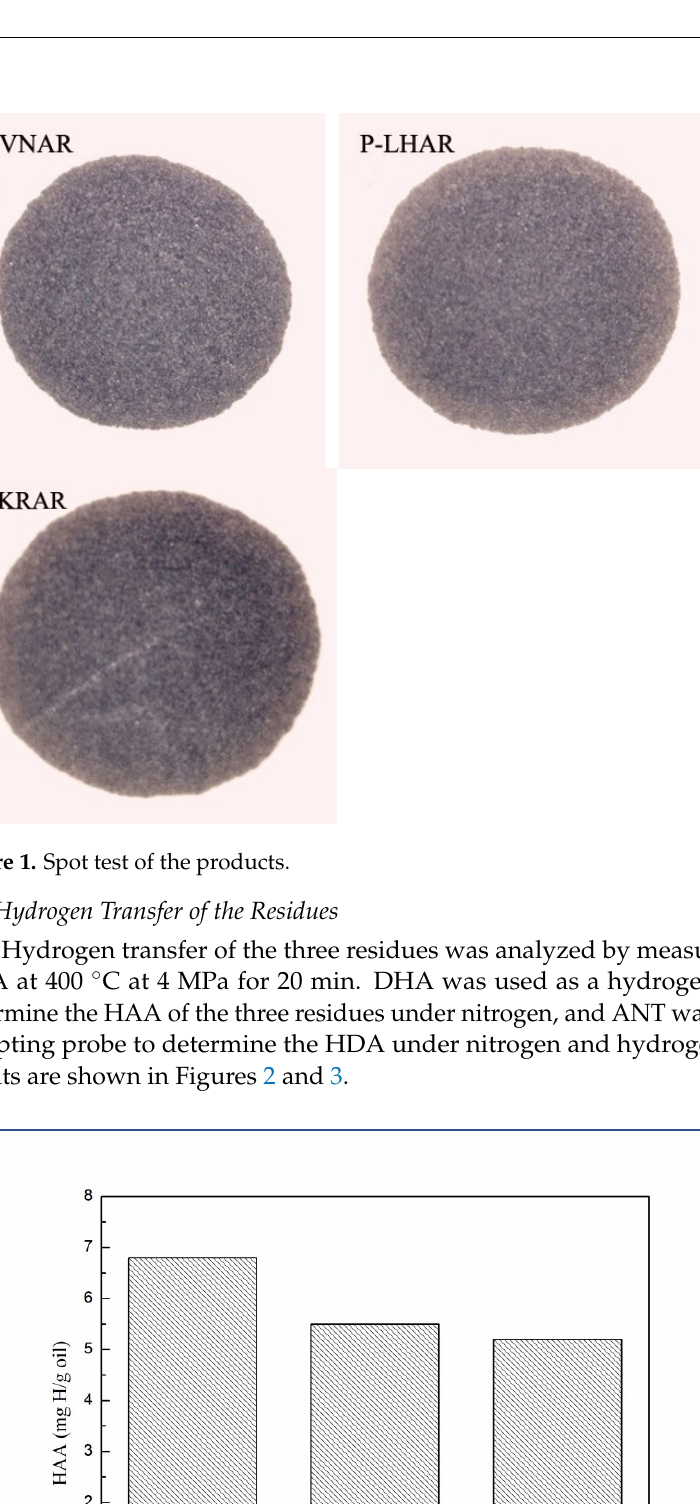
Figure 3. HDA of the three residues under hydrogen and nitrogen. 3.3. Activation of the Hydrogen In non ‐ catalytic conditions, the activation of hydrogen molecules is only related to the composition of the residue when the temperature and pressure are the same. Naph ‐ thenic aromatic structures were shown to play an important role in the activation of hy ‐ drogen molecules by acting as “hydrogen shuttle”. These structures can be hydrogenated and then donate the hydrogen out of which the process promotes the activation of hydro ‐ gen molecules. Thus, residues containing more naphthenic aromatic structures can acti ‐ vate more hydrogen molecules. As shown in Table 1, the number of paraffinic rings of the three residues is in the trend of VNAR > KRAR > LHAR. The number of paraffinic rings is directly related to the amount of naphthenic aromatic structures. Thus, VNAR and KRAR have greater advantages in terms of hydrogen transfer or hydrogen activation. However, the number of aromatic rings in VNAR is 4.039, which is even twice as much as